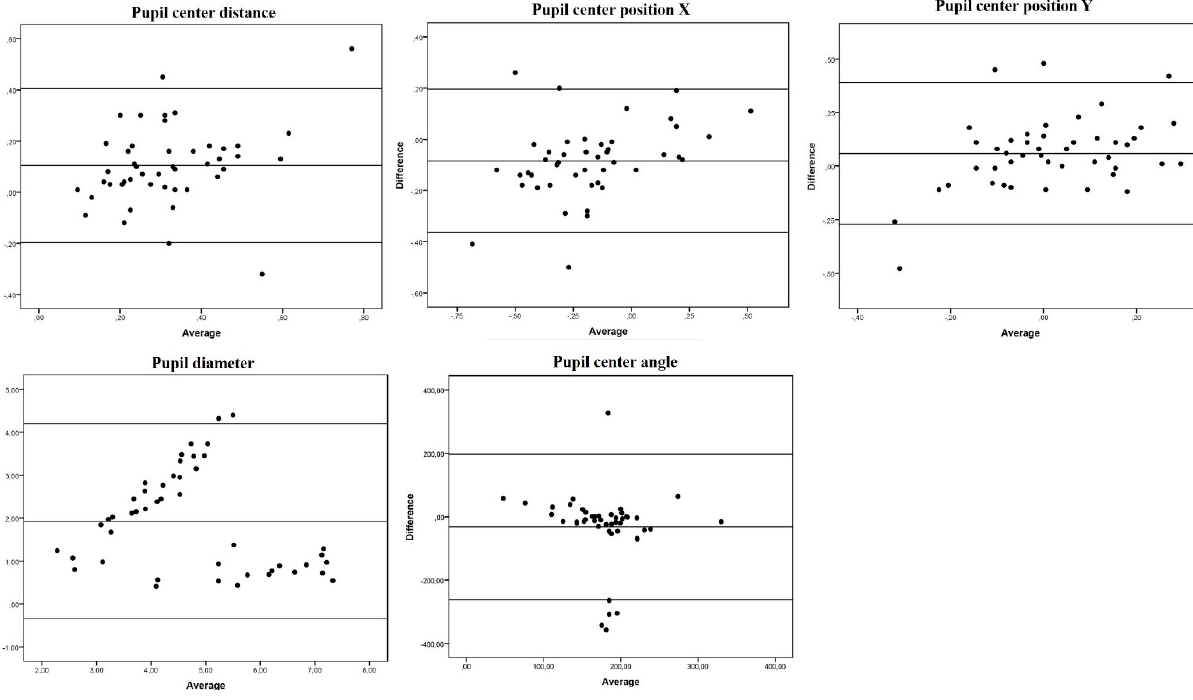
Figure 3. Bland-Altman plots of mean differences against averages of pupil measurements. Mean, lower and upper limits of agreement ( ± 1.96 SD, standard